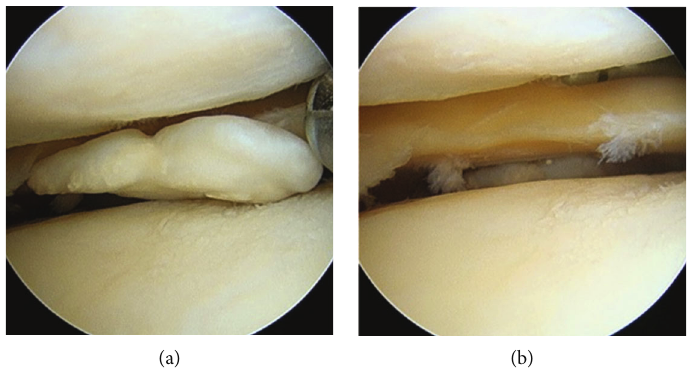
Figure 4: Arthroscopy. (a) Loose body removal. (b) Lateral compartment